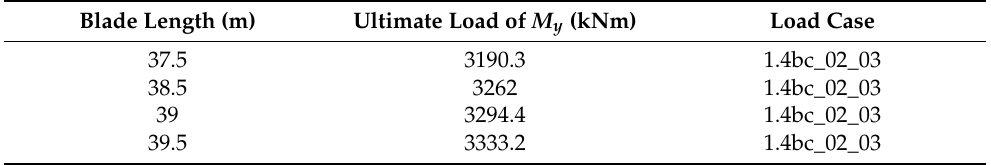
Table 14. Ultimate load M y at blade root. (The label of the load cases: the first letter refers to wind speed and “b” for 11.5 m/s; the second letter refers to yaw error, “c” for 8 deg; the middle number refers to wind direction change and 02 for negative direction change; the last number refers to start- ing azimuth angle and 03 for 60 deg). Blade Length (m)